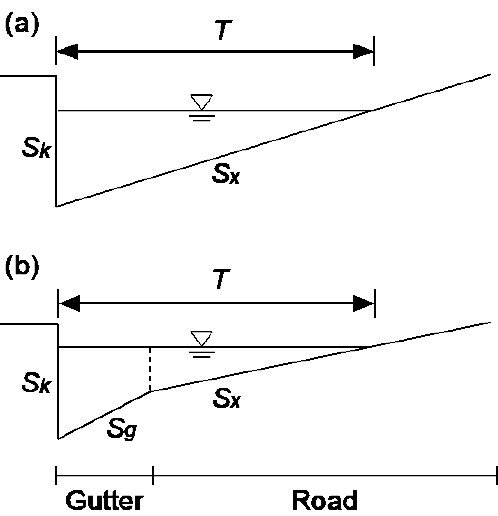
Figure 1. Cross-sectional shapes of gutter flows ( a ) uniform triangle gutter section, and ( b ) composite triangle gutter section; T : Flow width, S x : Transverse slope of the road, S g : Transverse slope of the gutter, and S k : Curbstones slope.